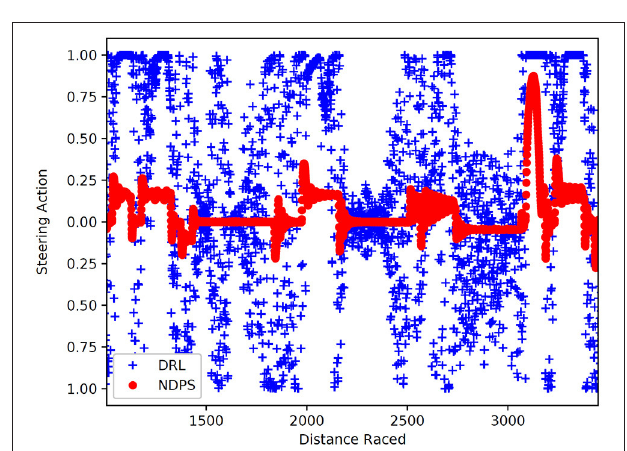
FIGURE 9 | Plot of steering actions generated by standard DRL agent vs. the summarized NDPS policy, which resulted in much smoother steering movements (from Verma et al., 2018, p. 7, reproduced with